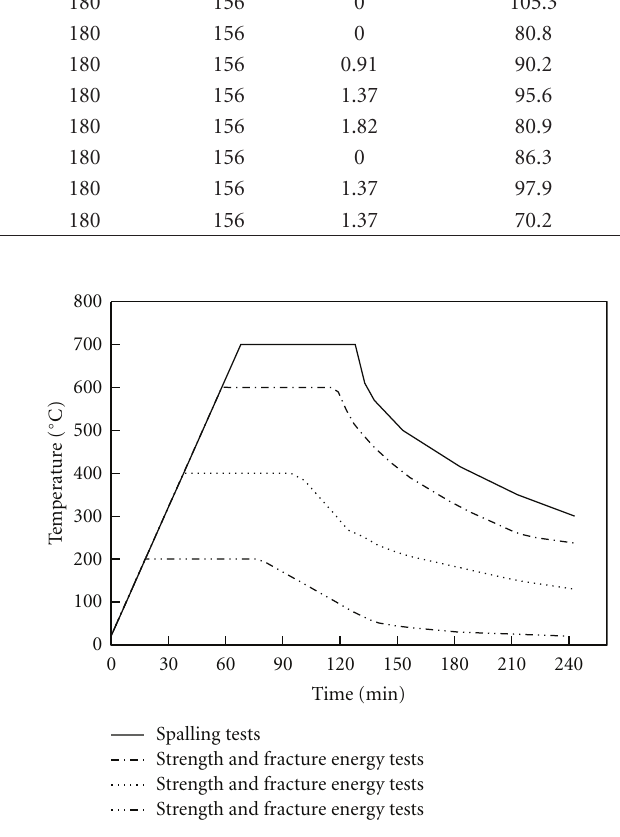
Figure 1: Temperature-time curves in heating of spalling test